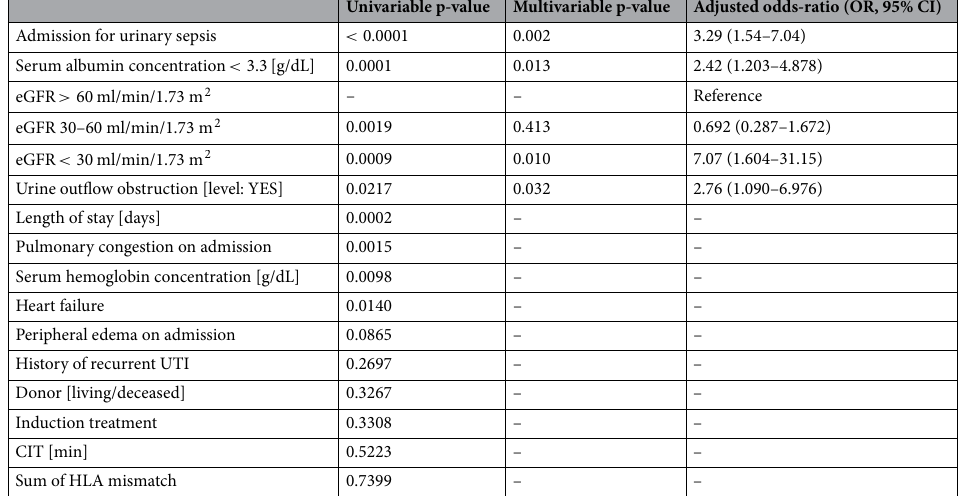
Table 3. Multivariable logistic regression model with retrograde variable elimination for risk factors of AKI development in KTRs with UTI and urosepsis.